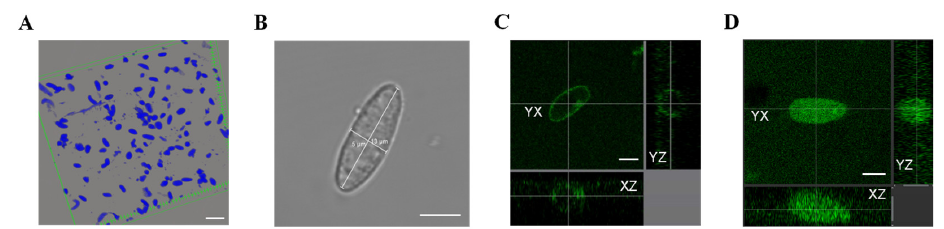
Figure 2. Morphology and free Ca 2+ fluorescence staining of isolated nucleus. ( A ) Isolated nuclei were stained by DAPI. Scale bar, 30 μm. ( B ) Single isolated myonucleus under bright field. Length and width were measured as shown. Scale bar, 5 μm. ( C ) Free Ca 2+ in nuclear envelope showed green fluorescence after loading Cal-520 AM (excitation, 493 nm; emission, 515 nm). ( D ) Free Ca 2+ in nucleocytoplasm showed green fluorescence after loading Cal-520 Dextran (excitation, 493 nm; emission, 515 nm). Scale bar, 5 μm. To observe the distribution of Ca 2+ fluorescence from more directions, the one myonucleus was observed in three orthogonal planes (YX plane, YZ plane, and XZ plane, as indicated by crossed dashed lines).